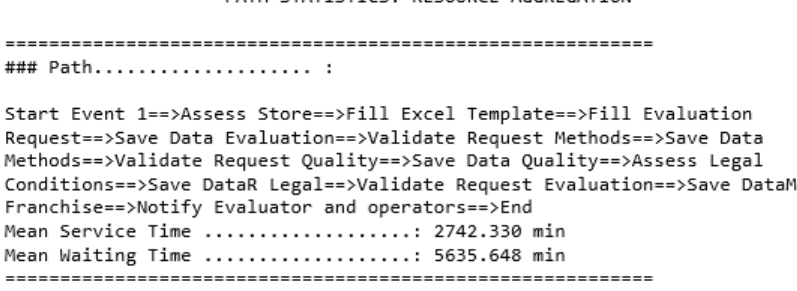
Figure 18. Global results for experienced human resource using resource aggregation.